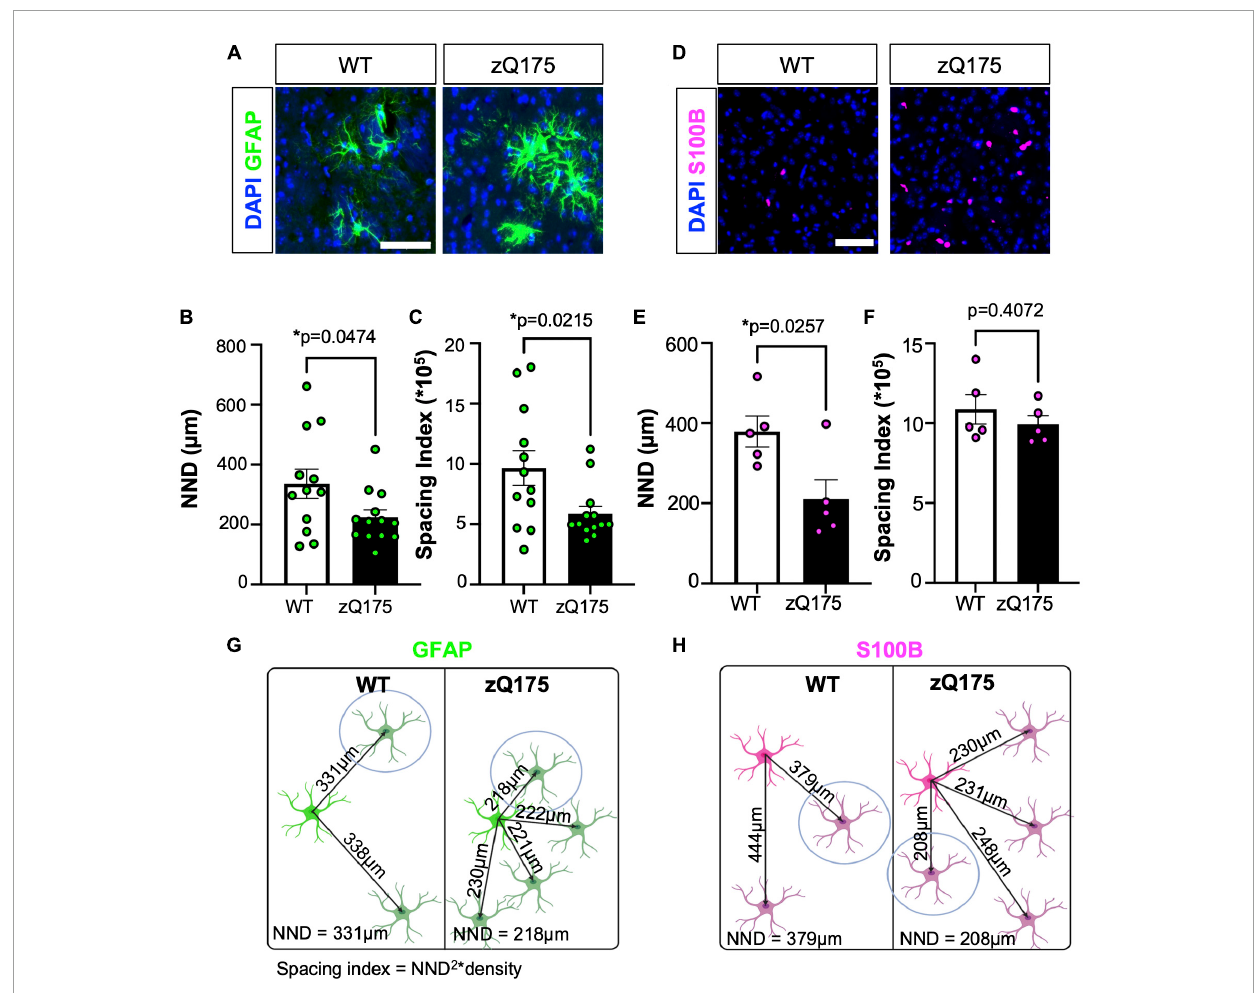
FIGURE3 GFAP + astrocytes in the dm striatum of zQ175 mice show increased clustering. (A) Representative immunostaining for GFAP in the striatum of WT and zQ175 mice at 12 months. DAPI stains nuclei. Scale bar, 50 µ m. NND (B) and spacing index (NND 2 × density) (C) between GFAP + astrocytes was calculated ( n = 12–13 mice/genotype). (D) Representative immunostaining for S100B in the striatum of WT and zQ175 mice at 12 months. DAPI stains nuclei. Scale bar, 50 µ m. NND (E) and spacing index (NND 2 × density) (F) between S100B + astrocytes was calculated ( n = 5 mice/genotype). Diagram representing changes in clustering for GFAP (G) and S100B (H) astrocytes. The cell circled in blue is the nearest neighbor. Created on BioRender.com. Error bars denote mean ± SEM. Un-paired Student’s t -test [ (B) t = 2.772, df = 23; (C) t = 2.425, df = 23; (E) t = 2.733, df = 8; (F) t = 0.8748, df = 8] * p <